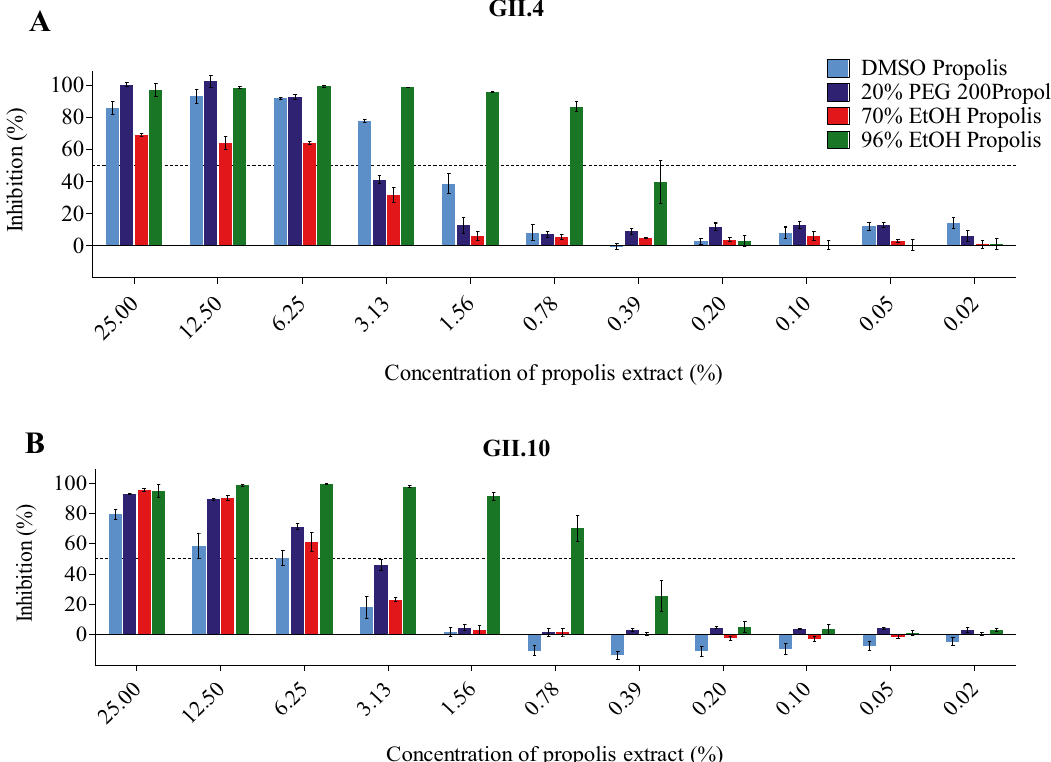
Figure 7. Propolis samples blocking GII.4 and GII.10 VLP attachment to HBGAs. VLPs were mixed with serially diluted propolis samples (100% DMSO propolis, 20% PEG200 propolis, 70% ethanol propolis, and 96% ethanol propolis) and HBGA attachment inhibition was measured using ELISA. The final concentration of the propolis extracts ranged between 25 and 0.02% (final concentration of solvents: DMSO 25–0.02%, PEG200 5–0.004%, 70%-ethanol 17.5–0.014%, and 90%-ethanol 24–0.0192%). All experiments were performed in triplicates and standard deviation is shown by the error bars. The IC 50 cutoff is shown by the dashed line. Overall, all propolis samples showed a dose-dependent inhibition. ( A ) For GII.4 VLPs, the lowest concentration of inhibition was observed with 96% ethanol propolis (IC 50 = 0.44%). ( B ) For GII.10 VLPs, the lowest concentration of inhibition was observed with 96% ethanol propolis (IC 50 =